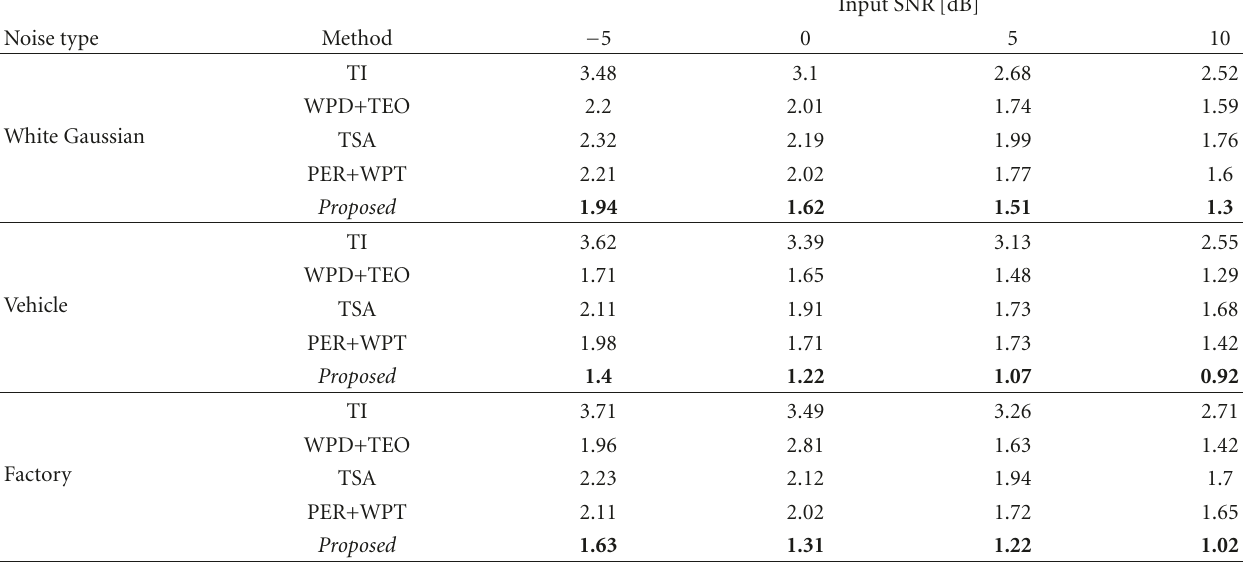
Table 2: The objective evaluation using IS